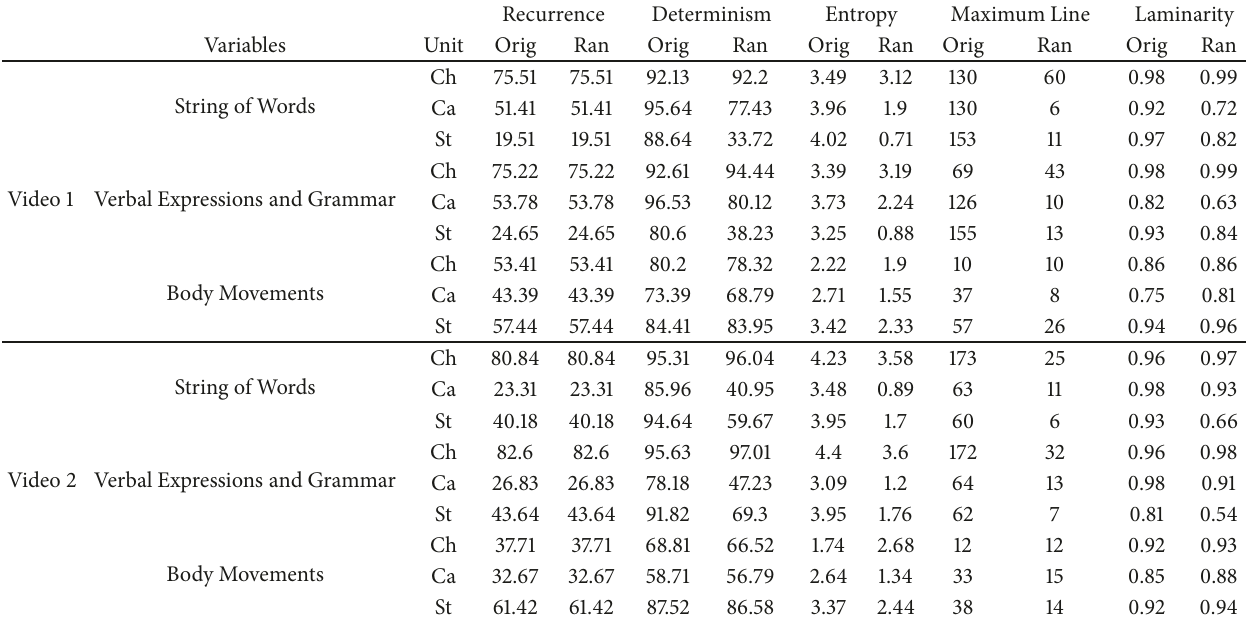
Table 4: RQA measures for individuals in Videos 1 and